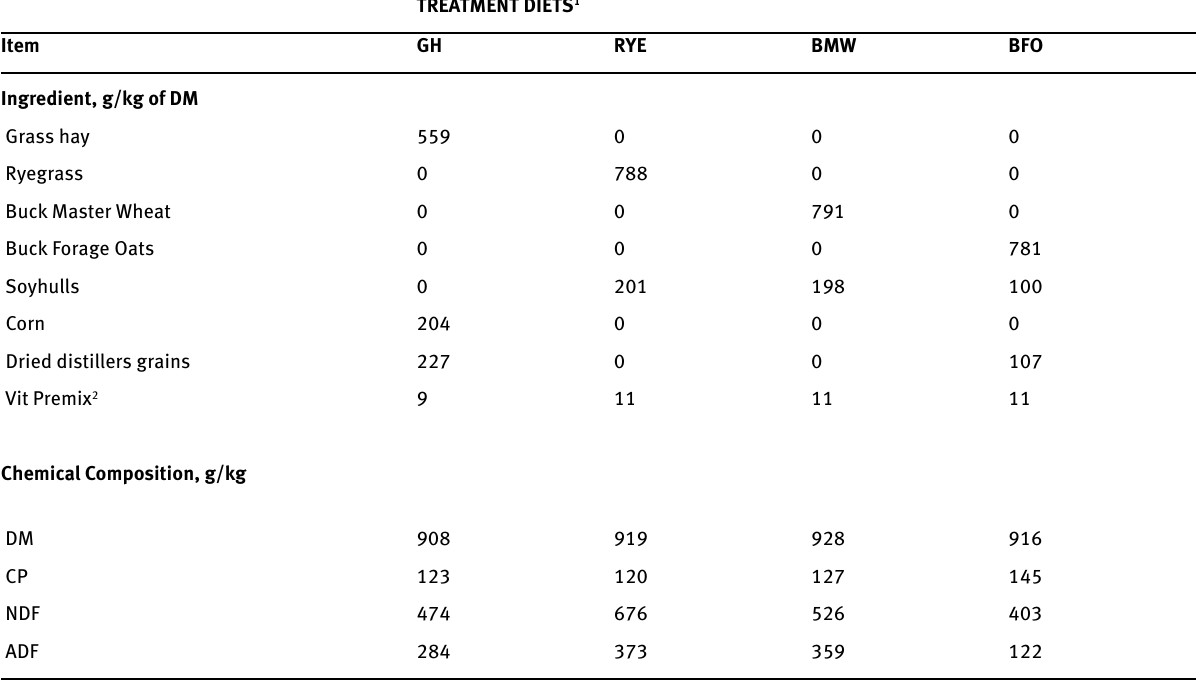
Table 1. Ingredients and analyzed composition of rations designed for developing heifers TREATMENT DIETS